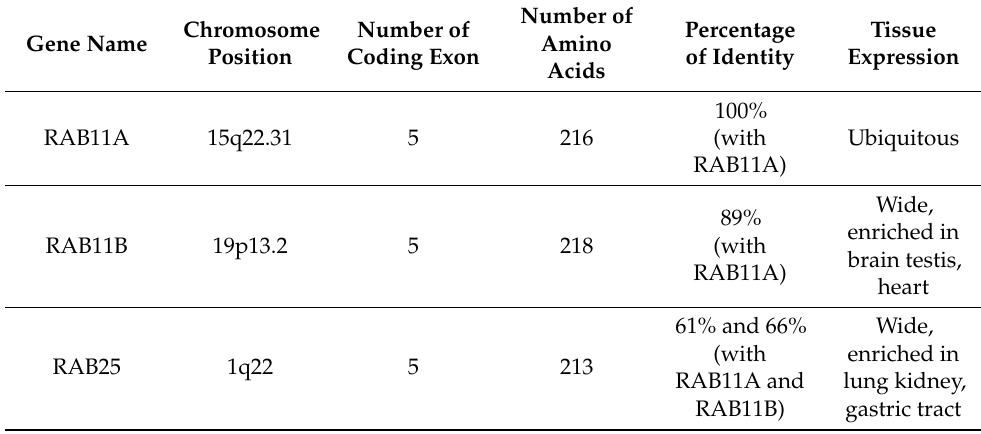
Table 1. Structure of RAB11 gene